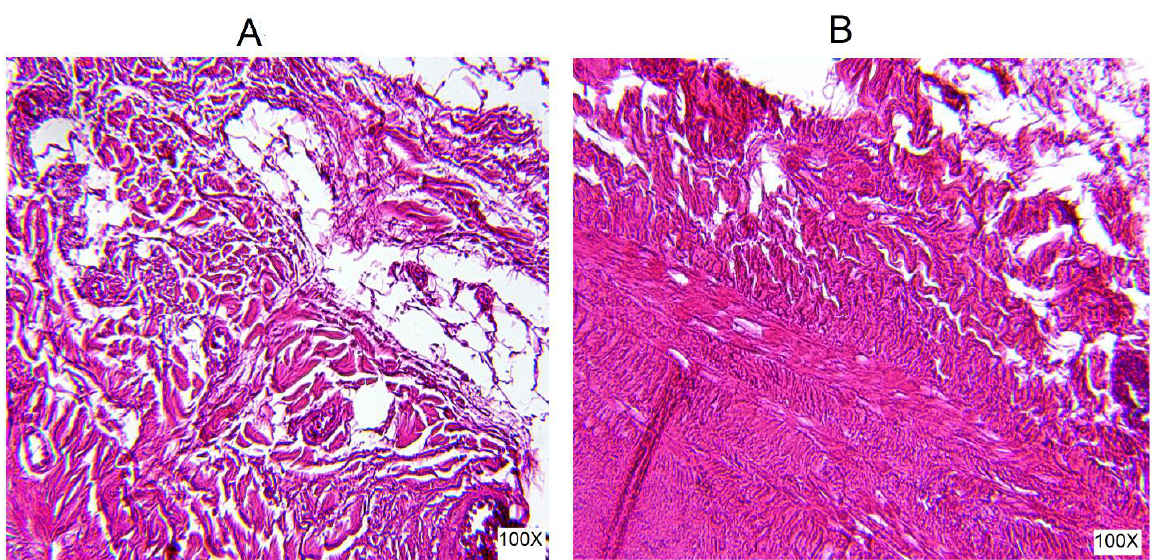
Figure 3: Case 2, A : Sacular aortic aneurysm, B: Opened aneurysm, C: Completed graft interposition of saccular aneurysm.